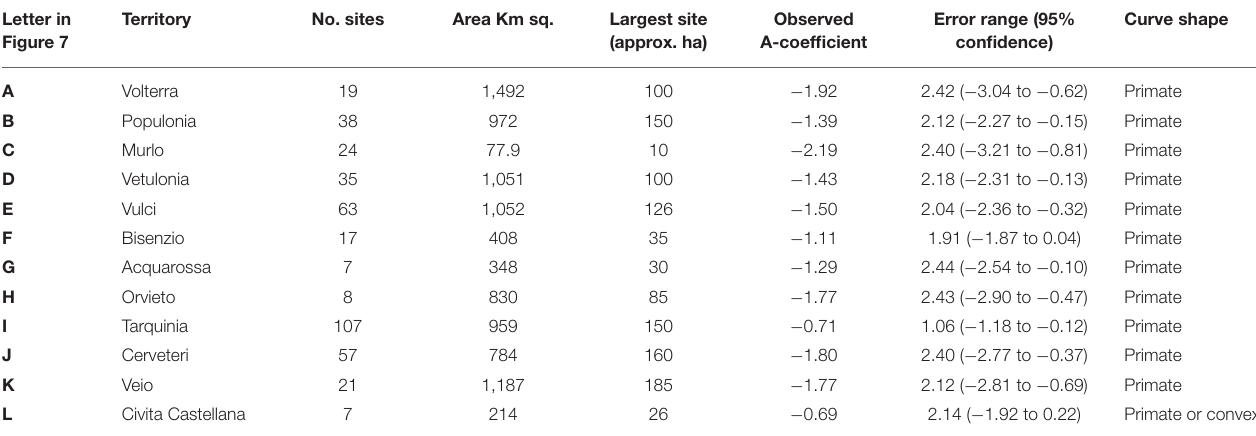
TABLE 3 | A-coefficient values and bootstrapped error ranges for log scale rank-size curves of the XTENT-defined territories in Etruria in the Iron Age/Orientalizing. Letter in Territory No. sites Area Km sq. Largest site Figure 7